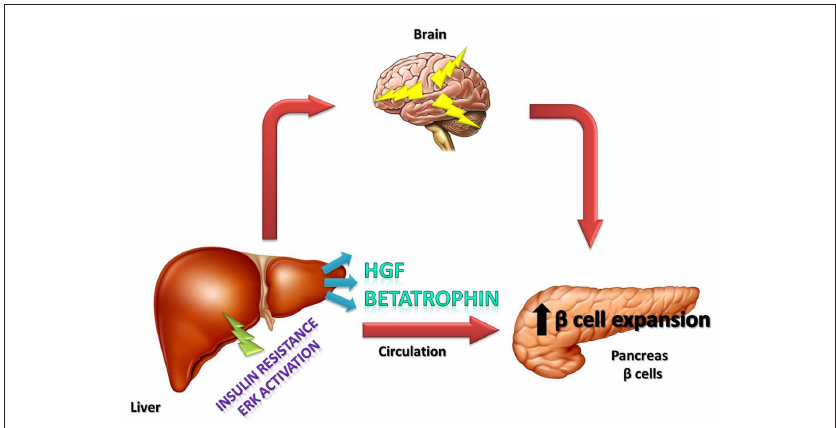
FiGure 1 | Schematic representation of the effects of betatrophin and HGF hormones, as well as, neural circuits on islets in which these components together induce the compensatory response to